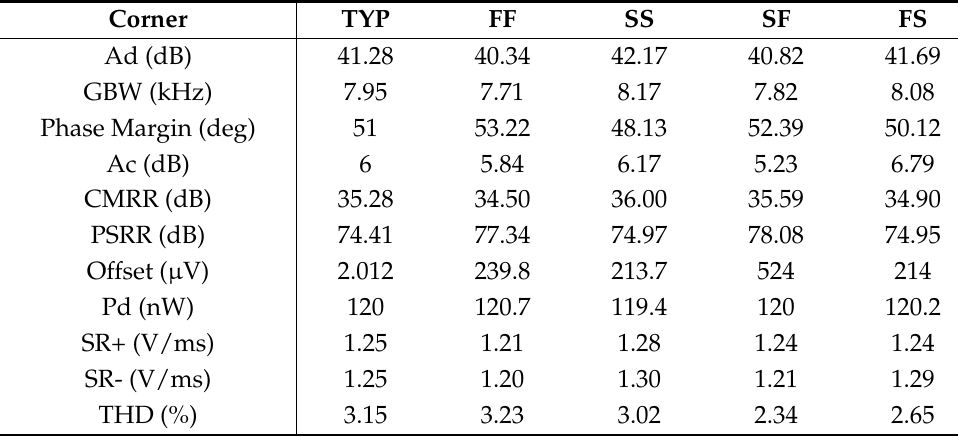
Table 3. OTA performance vs. process